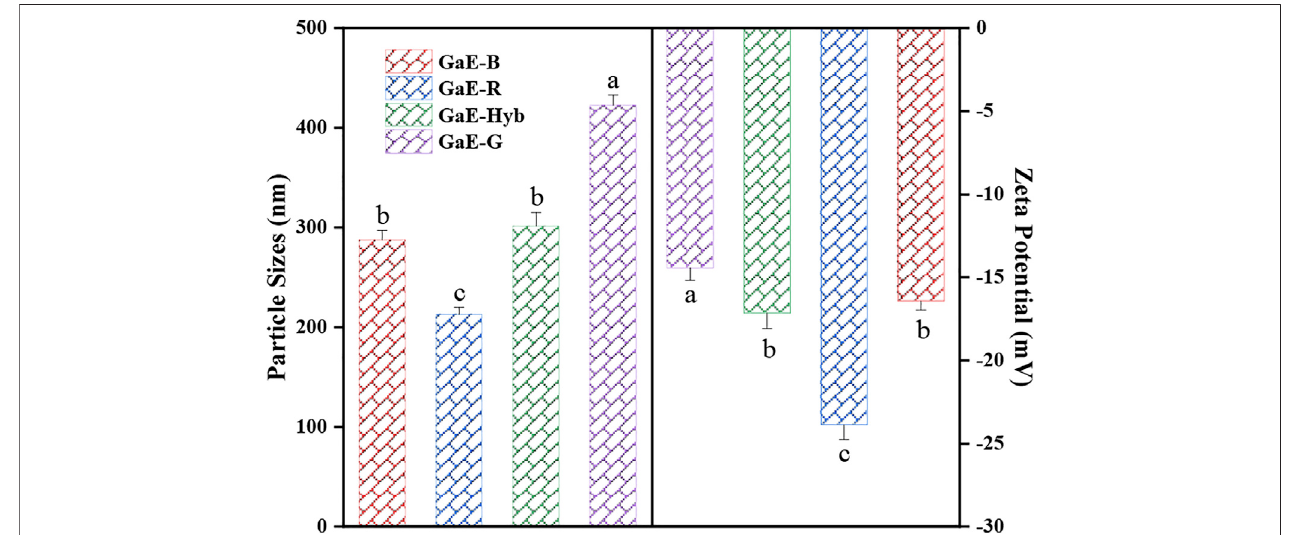
FIGURE 5 | Particle sizes and zeta potentials of the Gastrodia elata polysaccharides with four different varieties.